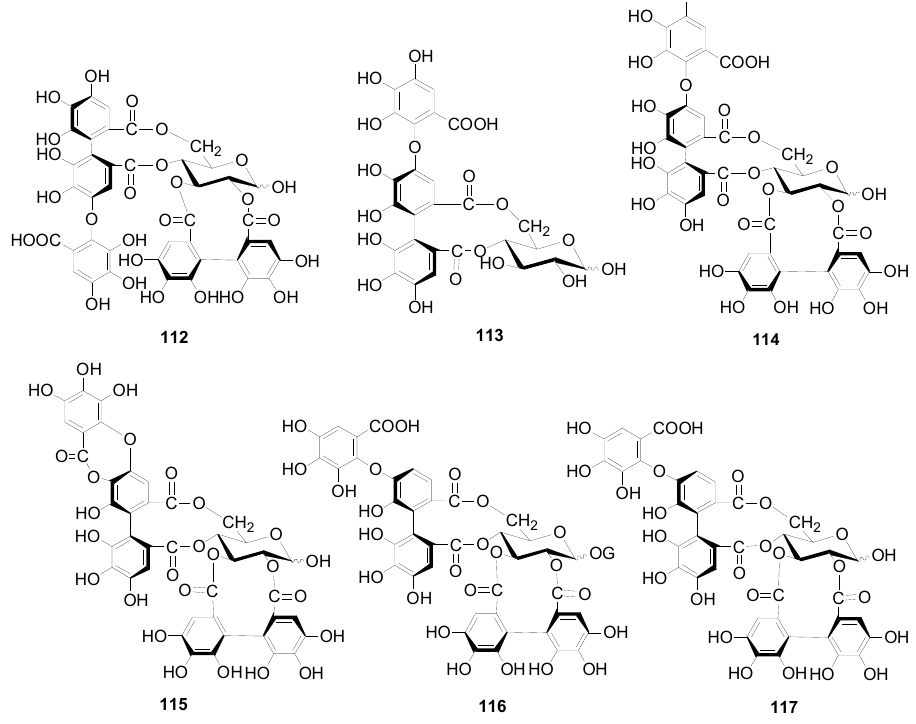
Figure 4. Structures of compounds 112 – 117 .